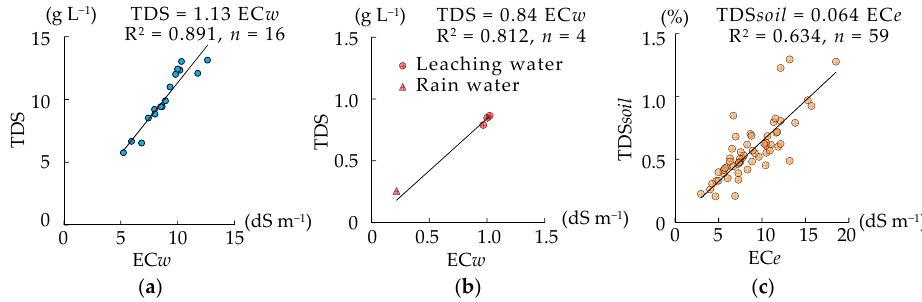
Figure 8. Correlation between electrical conductivity (EC) and total dissolved solid (TDS): ( a ) EC w and TDS in discharged water from the outlet of SSDC; ( b ) EC w and TDS in leaching water from canal